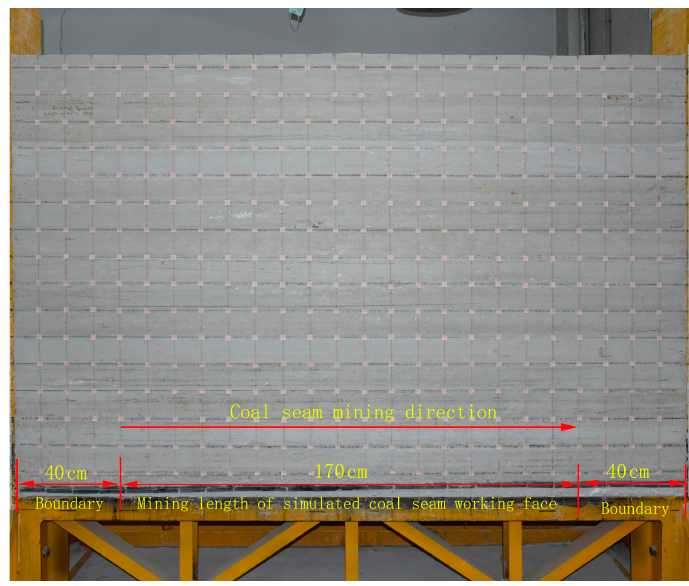
Figure 7. Established similar materials physical model.